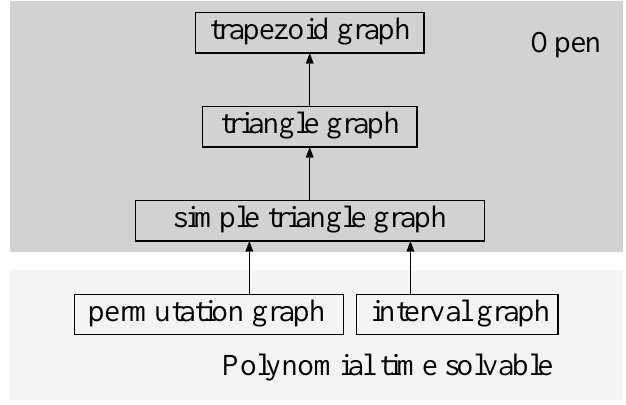
Fig. 3: Another hierarchy of the graph